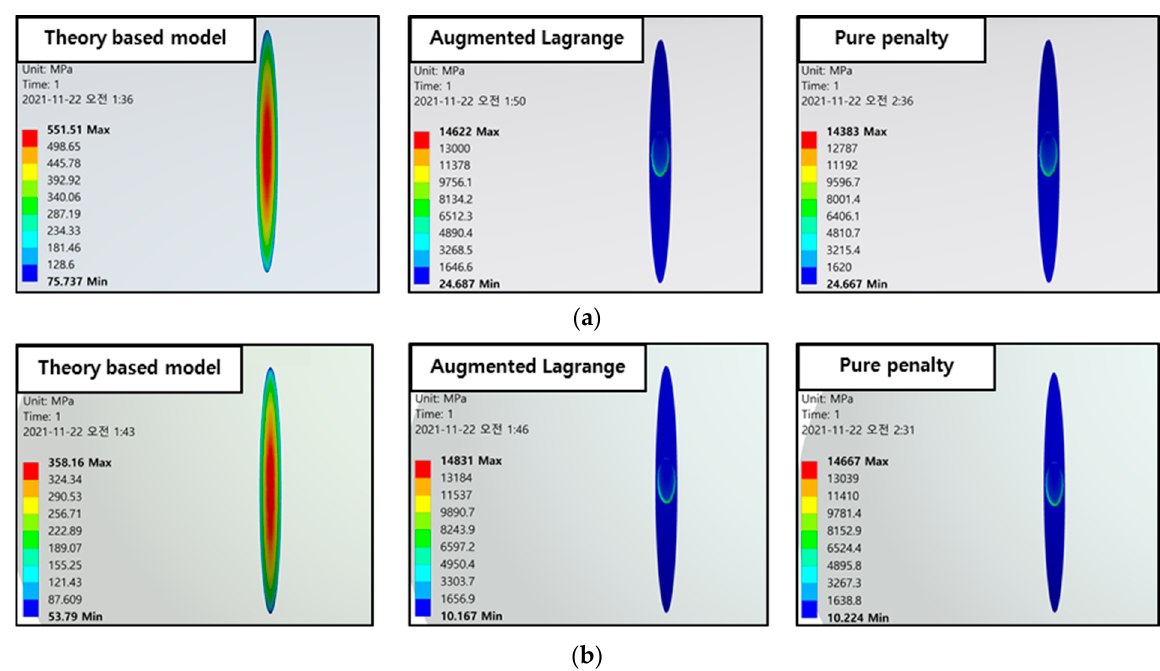
Figure 12. Equivalent stress (MPa) comparison on contact surface: ( a ) Shaft; ( b ) Ball.